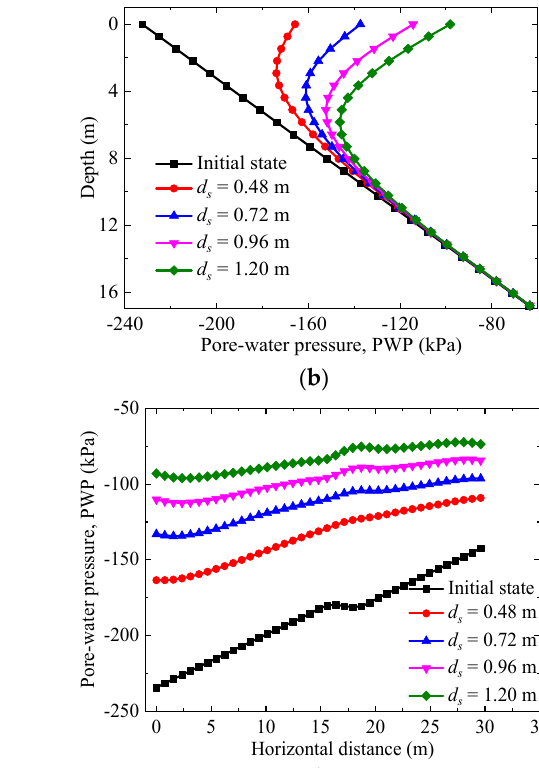
Figure 11. Investigation locations at the cutting slope.